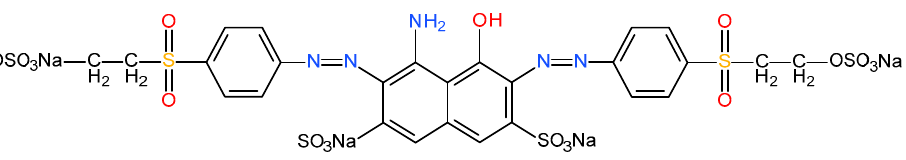
Figure 3. Chemical structure of Reactive Black 5 dye.